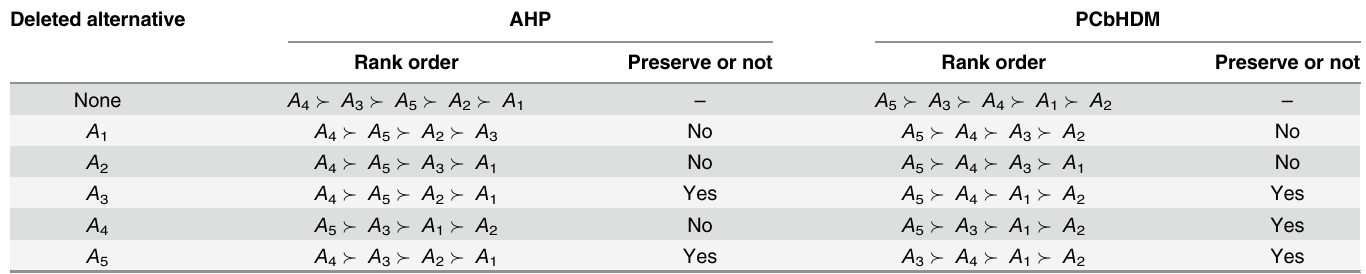
In contrast, the original AHP produces an overall priorities as: 0.251942, 0.219854, 0.260724, 0.267482, which indicate a final ranking as